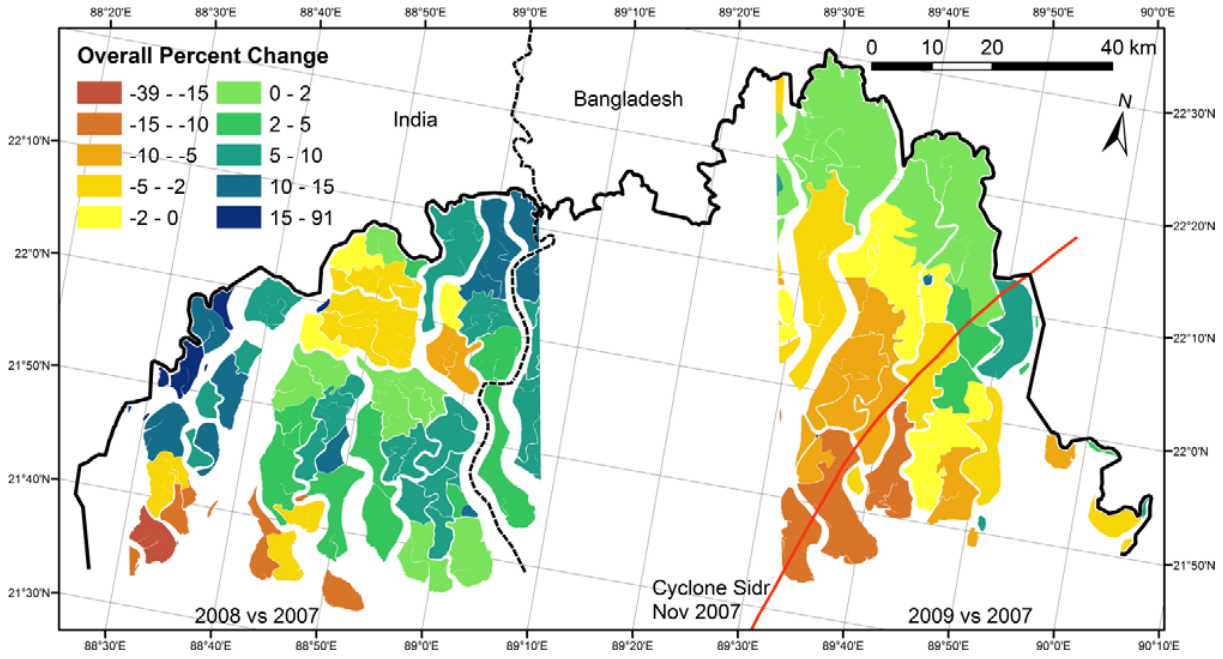
Figure 2. Spatial distribution of the overall percentage change in backscatter, considering only areas with increases and decreases of at least 10%, between 2007 and 2008 (for the west side of the Sundarbans) and 2007 and 2009 (for the east side of the Sundarbans), for each contiguous island as determined by the 7 × 7 filter. The red line represents the trajectory of cyclone Sidr, which struck Bangladesh on 15 November